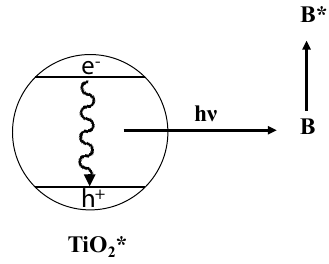
Figure 1. Trivial energy transfer